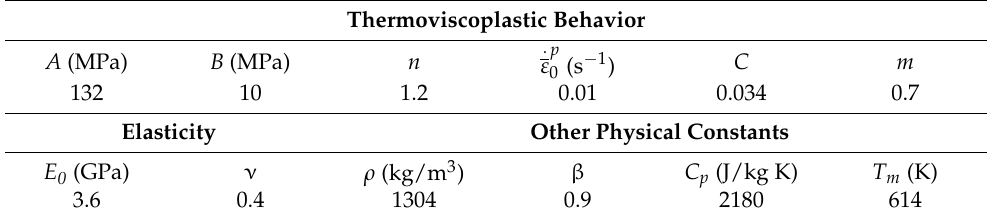
Table 1. Properties used to define the thermoviscoplastic behavior of PEEK